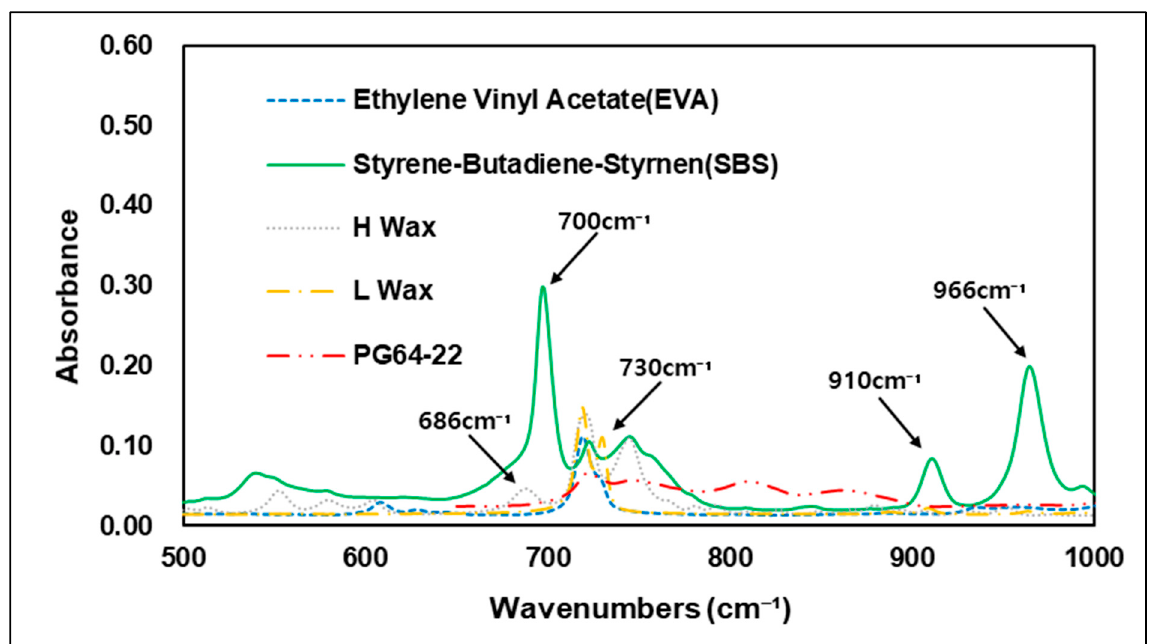
Figure 5. FTIR Spectrum of 500–1000 cm − ¹ area.